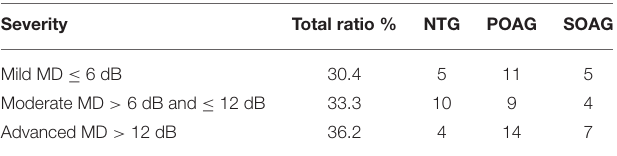
TABLE 1 | Classification of perimetric glaucoma patients (NTG, POAG, SOAG) into subgroups based on mean defect (MD, Octopus perimetry): mild, moderate, and advanced; ratio represents percentage of disease severity in all perimetric glaucoma